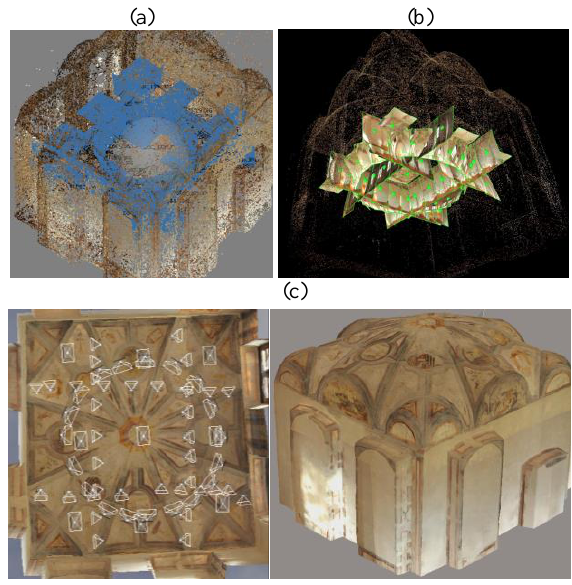
Figure 6. Results with different software for a room with a vault reconstructed with a fisheye lens.